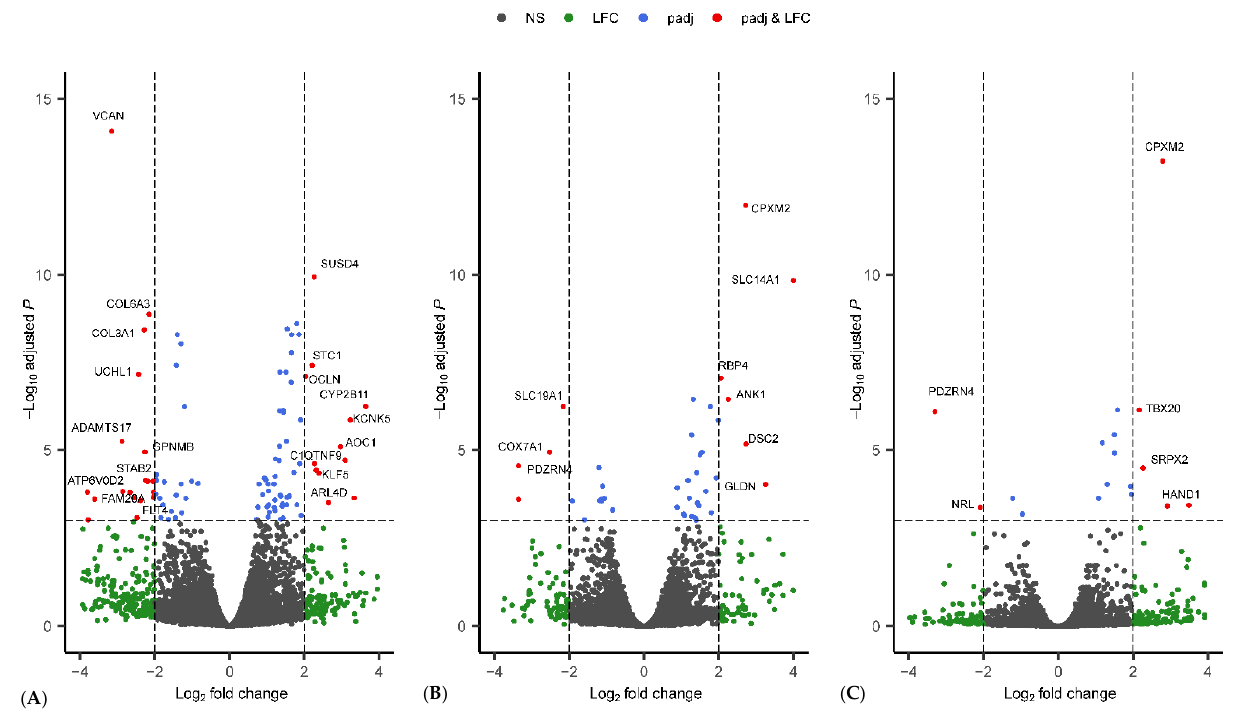
Figure 3. Volcano plot of genes that were expressed in the ( A ) metacarpal adipose tissue, ( B ) perirenal adipose tissue, and ( C ) prescapular adipose tissue. Significantly differentially expressed genes are marked with their gene names. For the complete list of differentially expressed genes, please see Tables S4–S6. In figure, NS = non-significant; LFC = absolute Log 2 fold change greater than 2; padj = adjusted p value less than 0.001; and padj and LFC represent genes that fulfil the criteria of threshold for LFC and